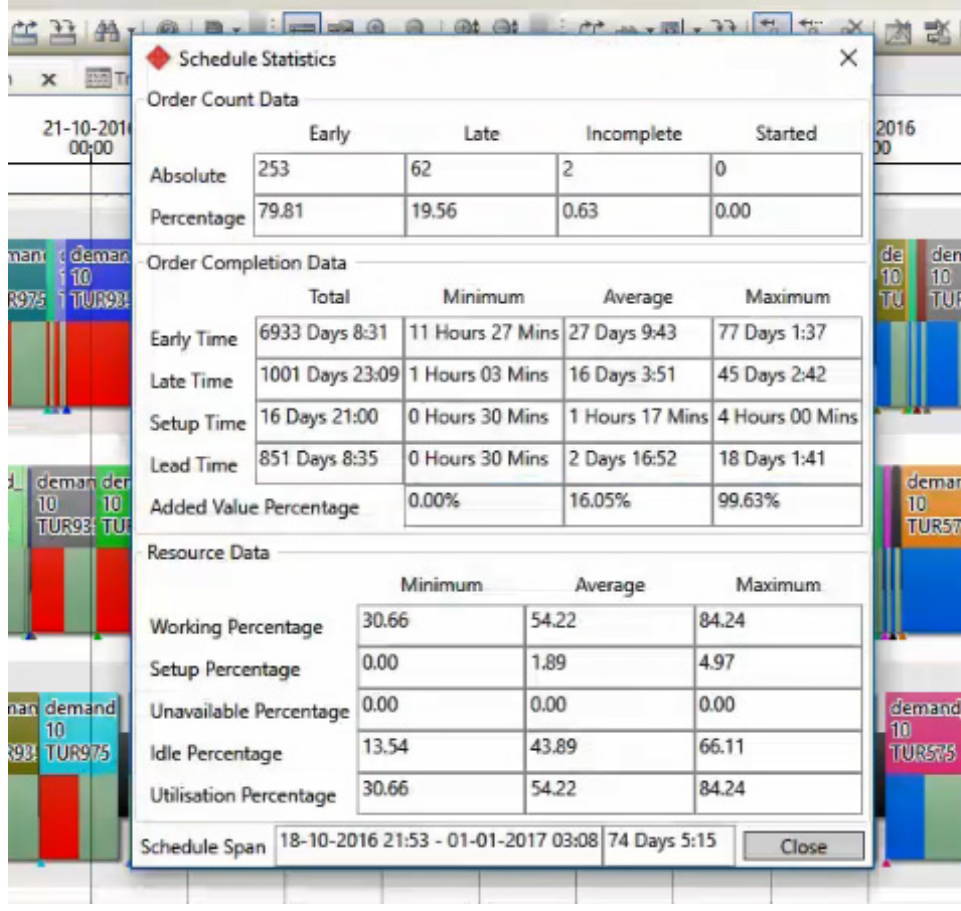
Figure 9. Material glass grouping-results-Siemens Opcenter APS preview.